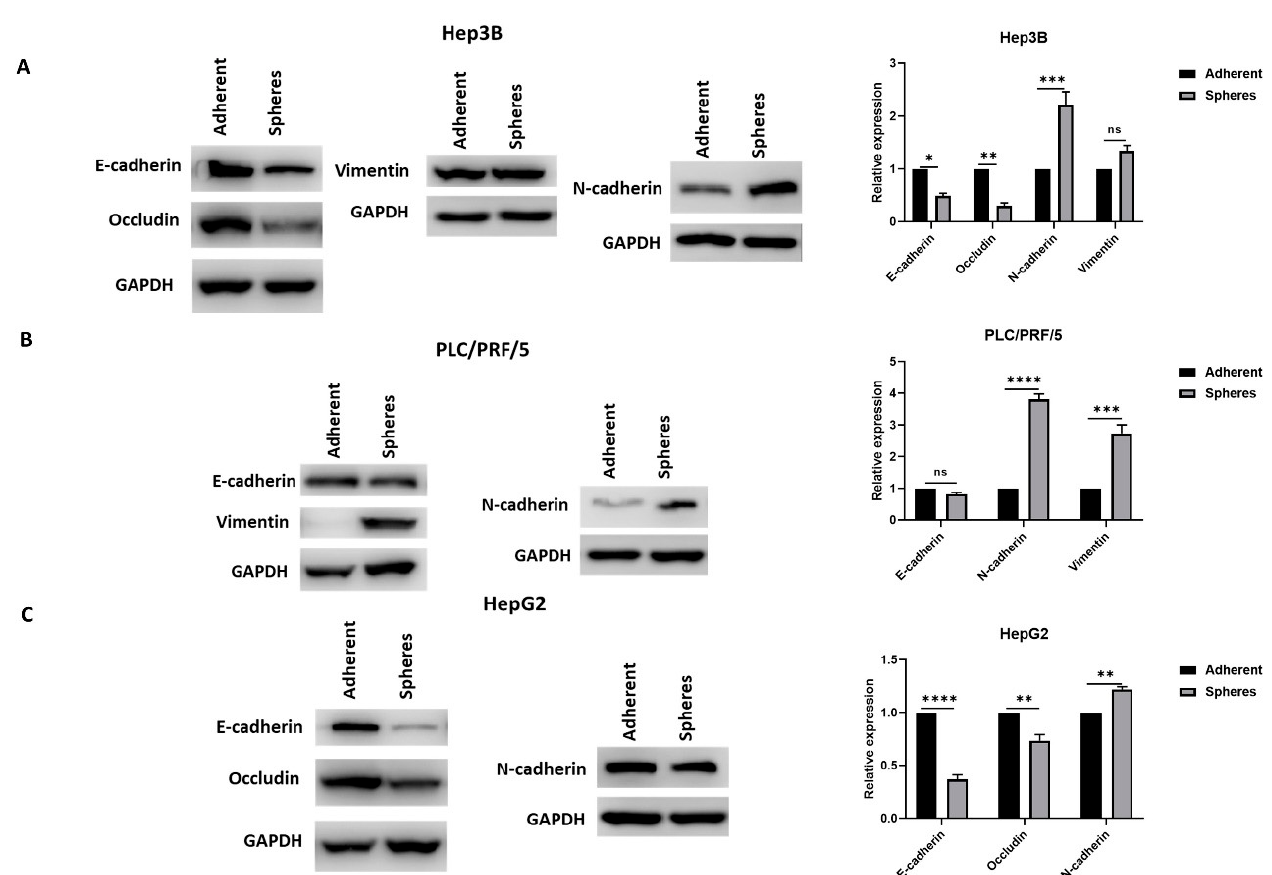
Figure 4. Human HCC-derived spheres exhibit mesenchymal phenotype. Western blot analysis revealed ( A ) a decrease in E-cadherin and Occludin expression and an increase in N-cadherin and Vimentin expression in Hep3B-derived spheres compared to adherent cells, ( B ) reduced expression of E-cadherin and elevated expression of N-cadherin and Vimentin in PLC/PRF/5-derived spheres compared to adherent cells, and ( C ) reduced expression of E-cadherin and Occludin and elevated expression of N-cadherin in HepG2-derived spheres compared to adherent cells. Detailed information about Western Blot can be found at Supplementary Materials. ( n = 3, * p < 0.05, ** p < 0.01, *** p < 0.005, **** p < 0.001, ns: not significant).